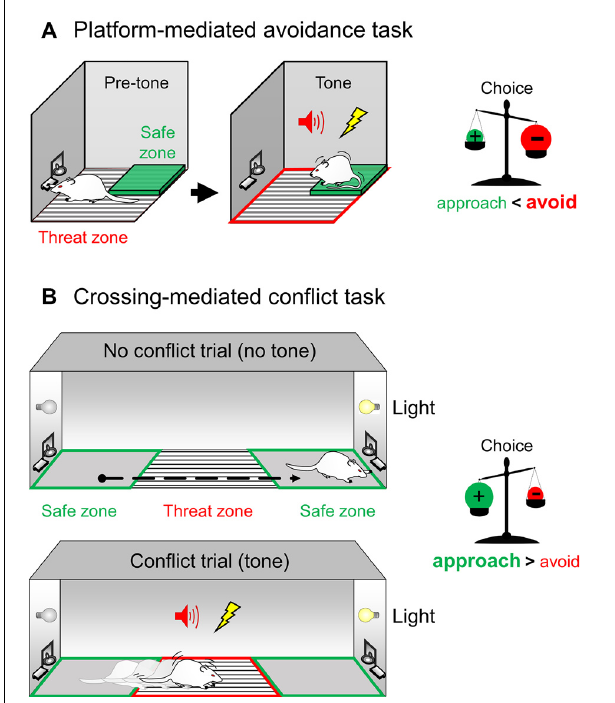
FIGURE 2 | Novel behavioral assays to probe competing aversive and reward memories during a conflict. (A) Left . In the platform-mediated avoidance (PMA) task, rodents pressing a lever for reward are presented with a warning tone that predicts the onset of a foot-shock. Rodents then must step onto a safety platform opposite to the reward dispenser to avoid the punishment. PMA poses a conflict for rodents, where they must choose to seek safety during the warning signal at the expense of reward attainment during that period. Right . Thus, in PMA, during tone presentation the choice is balanced towards expressing the aversive negative memory (+) over the reward positive memory ( − ), leading the animal to avoid the grid rather than approach the reward (the avoidance drive is stronger than the approach drive). (B) Left . In the crossing-mediated conflict (CMC) task, a rodent trained to press a lever for reward is placed on one end of a straight alley and must cross a grid to obtain a light-signaled reward on the safe zone on the opposite side of the alley (no-conflict trials). However, the same animal also learns that a warning tone predicts a foot-shock in the threat zone (conflict trials). CMC poses a conflict for rodents, where they must discriminate between trials and choose to overcome fear to obtain a reward. Right . Thus, in CMC, during tone-signaled conflict trials, the choice is balanced towards expressing the reward positive memory (+) over the aversive negative memory ( − ), leading the animal to cross the grid to obtain the reward despite the threat (the approach drive is stronger than the avoidance drive).